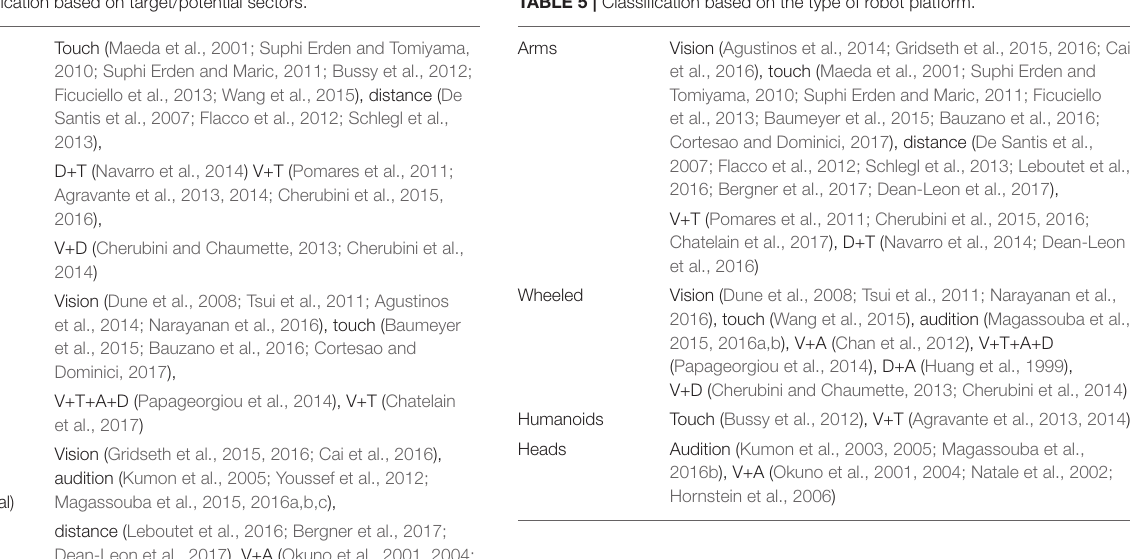
TABLE 5 | Classification based on the type of robot